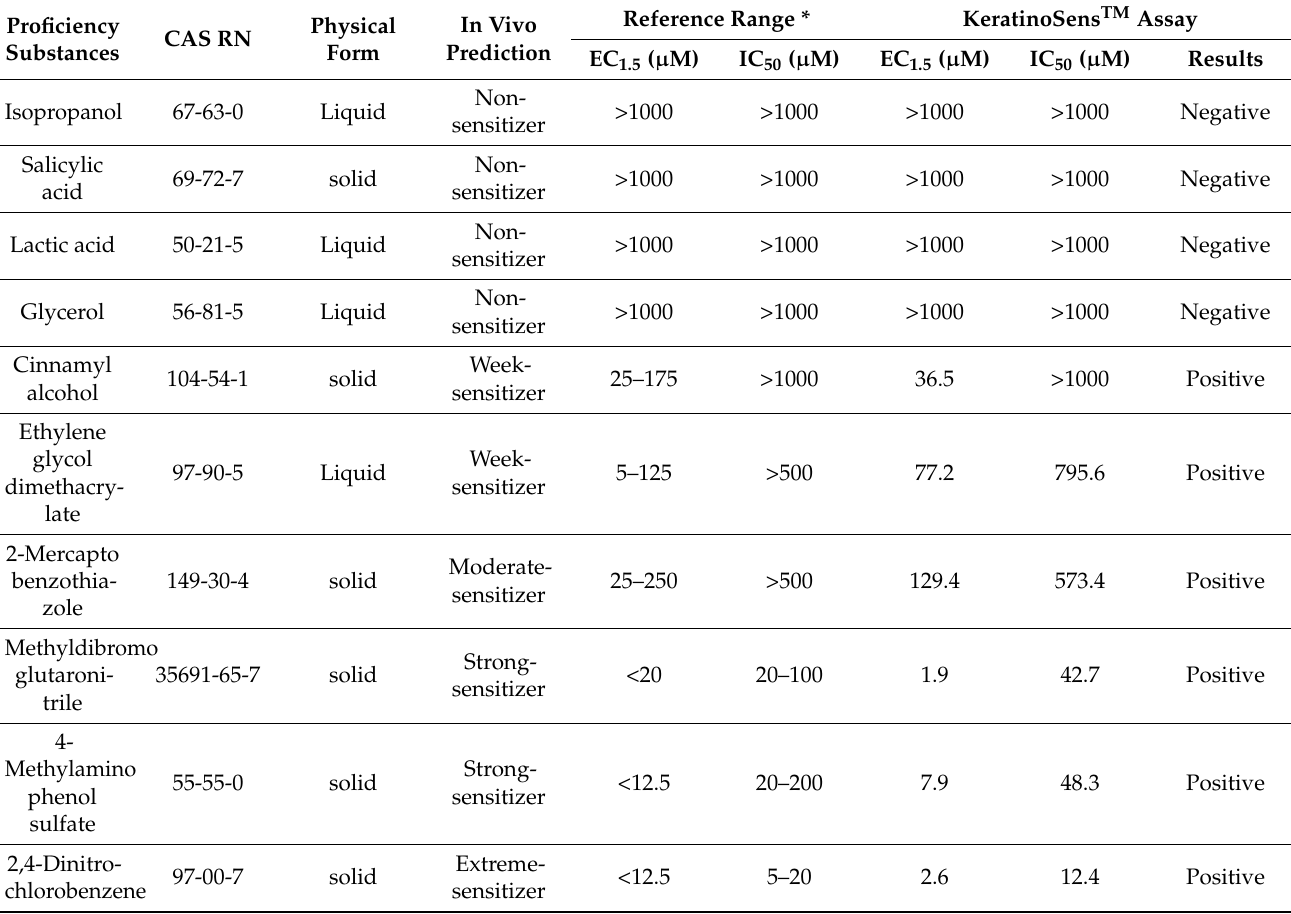
Table 2. Demonstrating technical proficiency of the KeratinoSens TM test method.